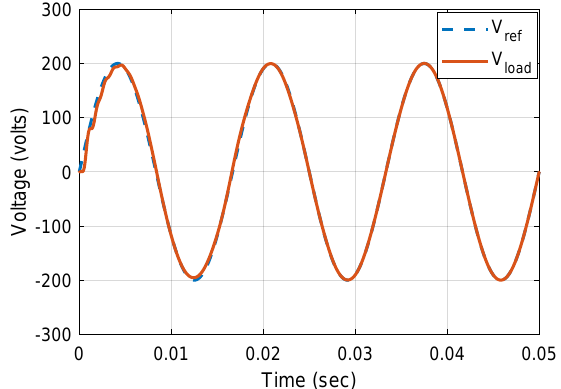
Figure 15. Time response of the sequentially-designed decentralized controllers for 500 (m) distance between the inverters and ± 20% variations in the parameters of the LC filters and the interconnec- tion line.